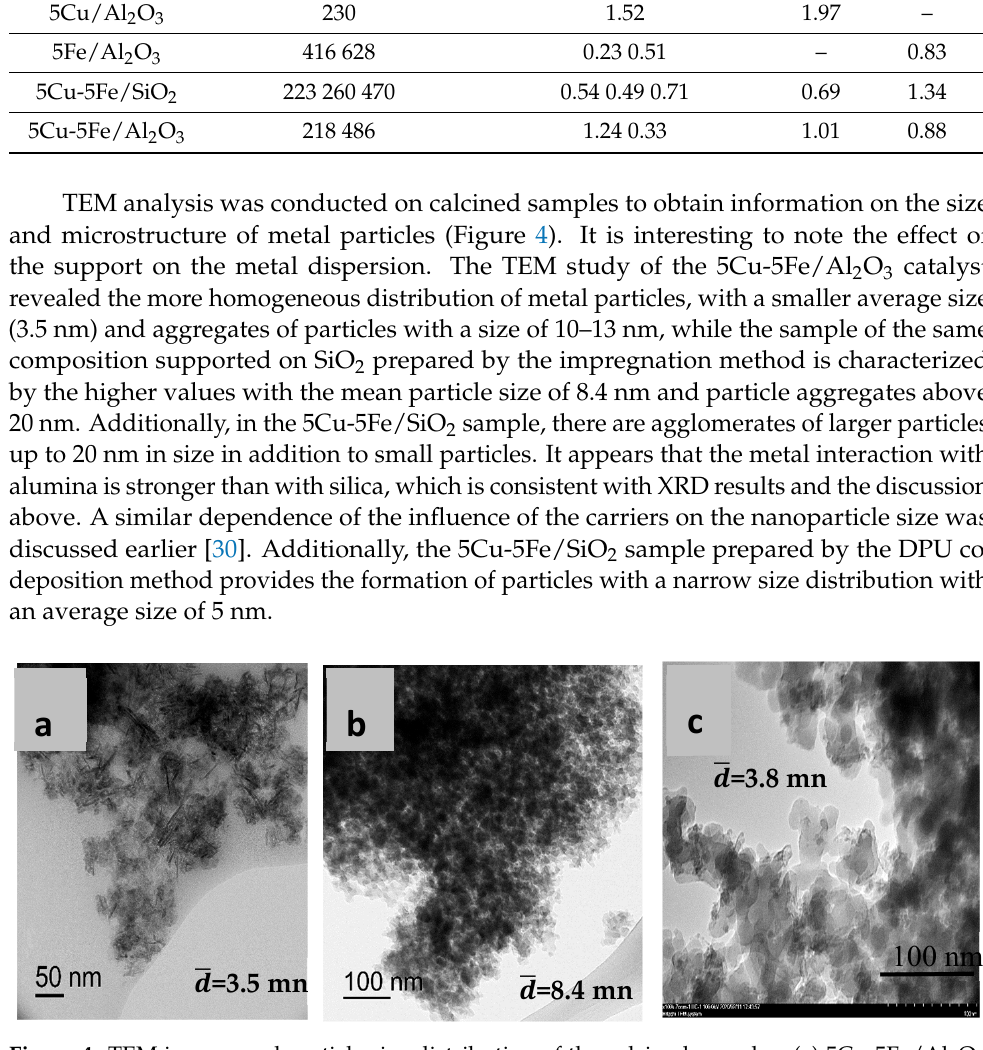
Figure 4. TEM images and particle size distribution of the calcined samples: ( a ) 5Cu-5Fe/Al 2 O 3 ; ( b ) 5Cu-5Fe/SiO 2 ; ( c ) 5Cu-5Fe/SiO 2 prepared by the DPU method.